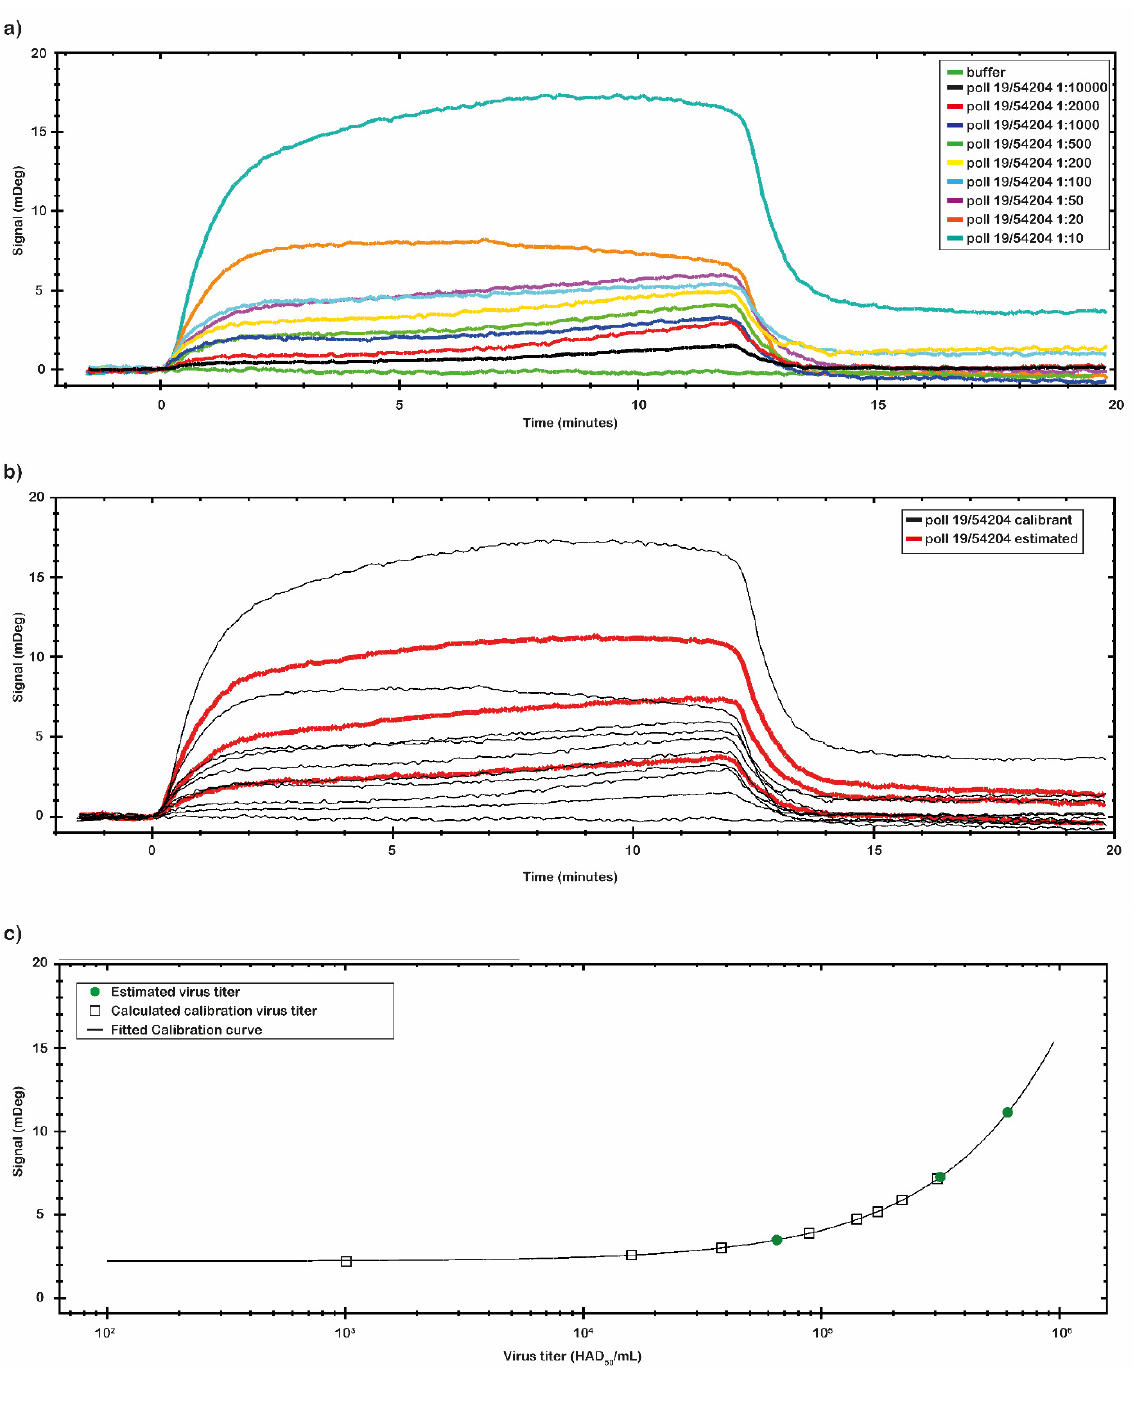
Figure 6. SPR experiments with ASFV sample. ( a ) Concentration through calibration (CTC) analysis on ASFV Pol19/54204 samples. ( b ) CTC analysis was performed with the ASFV sample in a range from 0 to 1 × 10 6 (HAD 50 / mL ) (black line) that was used as the calibrant, while another set of ASFV Pol19/54204 samples was estimated (red line). All measurements were performed in 10 mM NaP pH 7.4 buffer at room temperature. ( c ) The mDeg values were plotted against the ASFV calibrant sample concentrations (black square) and fitted by a Four Parameter Eq Lo Hi model. The obtained calibration curve (black line) was used to estimate the concentration of the second set of ASFV samples analyzed (green circle).